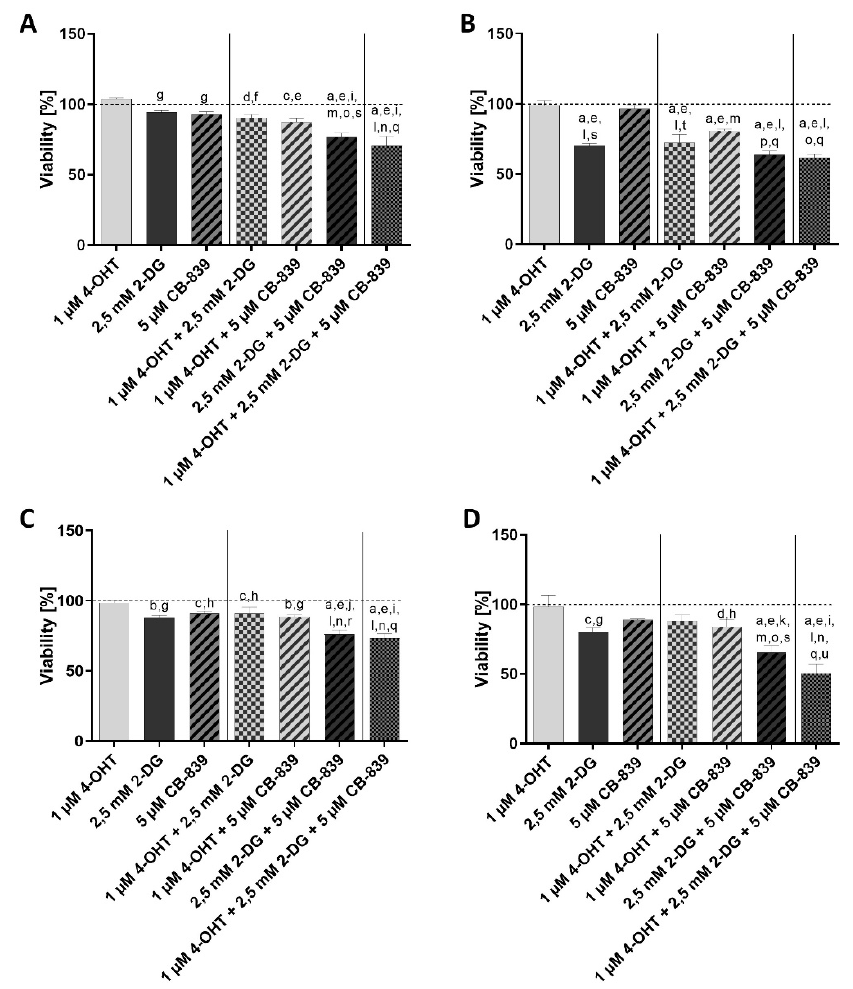
Figure 2. Viability of human breast cancer cell lines MCF7 ( A ), T47D ( C ) and their tamoxifen-resistant sublines MCF7-TR ( B ) and T47D-TR ( D ) after treatment with or without 4-OHT, 2-DG or CB-839 or different combinations. Columns represent means ± SEM of data obtained from three independent experiments in three different passages of the cell lines. a, p < 0.0001 vs. control; b, p < 0.001 vs. control; c, p < 0.01 vs. control; d, p < 0.05 vs. control; e, p < 0.0001 vs. 1 μ M 4-OHT; f, p < 0.001 vs. 1 μ M 4-OHT; g, p < 0.01 vs. 1 μ M 4-OHT; h, p < 0.05 vs. 1 μ M 4-OHT; i, p < 0.0001 vs. 2.5 mM 2-DG; j, p < 0.001 vs. 2.5 mM 2-DG; k, p < 0.05 vs. 2.5 mM 2-DG; l, p < 0.0001 vs. 5 μ M CB-839; m, p < 0.001